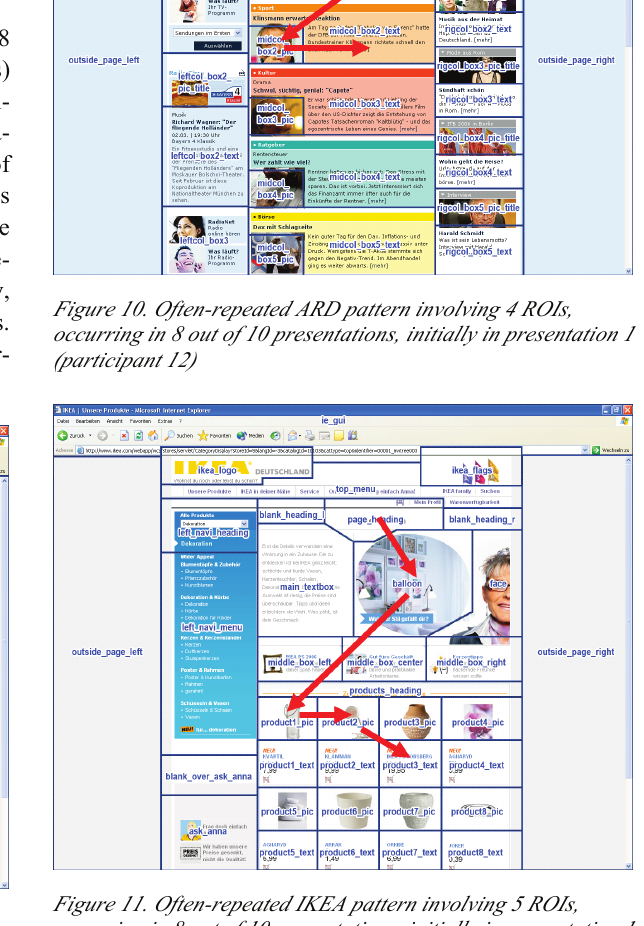
Figure 9. Long IKEA pattern involving 8 ROIs, occurring in 5